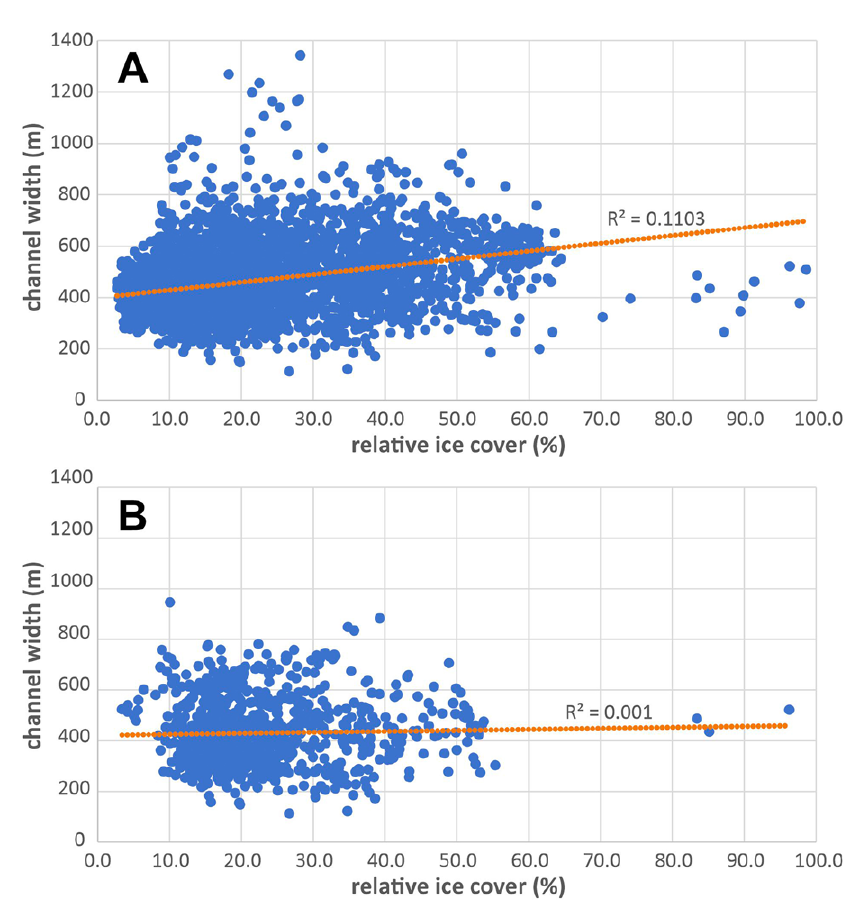
Figure 14. The relationship of width and ice cover A) on the entire study reach and B) on the reach of Zone II. with highly variable width